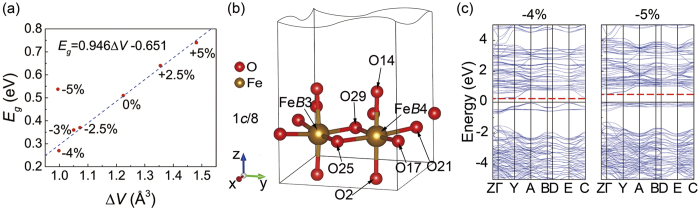
(a) The band gap Eg with the average FeO6 volume difference at different strains. (b) The local structure of Fe(B4) under P2/c symmetry. (c) The band structure of structure (I) with −4% and −5% compressive strain in left and right panel, respectively.